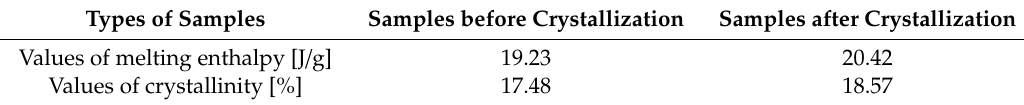
Table 4. Comparison of the crystallinity degree of samples before and after the crystallization process. Types of